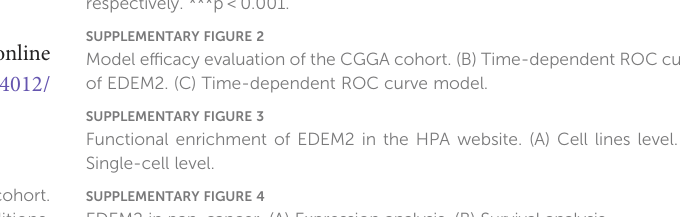
SUPPLEMENTARY FIGURE 1 Differential expression and survival analysis of subgroups in the CGGA cohort. (A-C) EDEM2 expression differences in different pathological conditions,